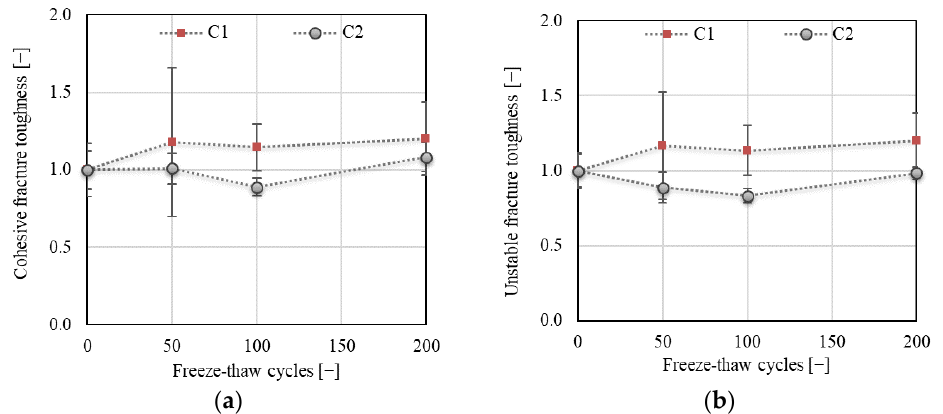
( b ) Figure 15. ( a ) Equivalent elastic crack extension; ( b ) critical crack-tip opening displacement (CTOD). Figure 15b shows an increase in the value of CTOD c of more than 60% for C1 after 200 F–T cycles. This indicates an increase in the fictitious crack width before the failure due to F–T exposure. An increase of about 34% followed by a steep decrease of about 50% was recorded for C2 after 50 F–T cycles. This indicates a gradual increase in brittleness of C2 with an increasing number of F–T cycles. The above results correspond to the results of fracture toughness obtained using the 2K model. As shown in Figure 16 or Figure 17a, an increase of about 20% was recorded for C1 concrete for cohesive ( K Icc ), unstable ( K Icun ), and initial fracture ( K Icini ) toughness after 50 F–T cycles, after which all toughness components were already stabilized during the remainder of the F–T test. In the case of concrete C2, the trend of development slightly